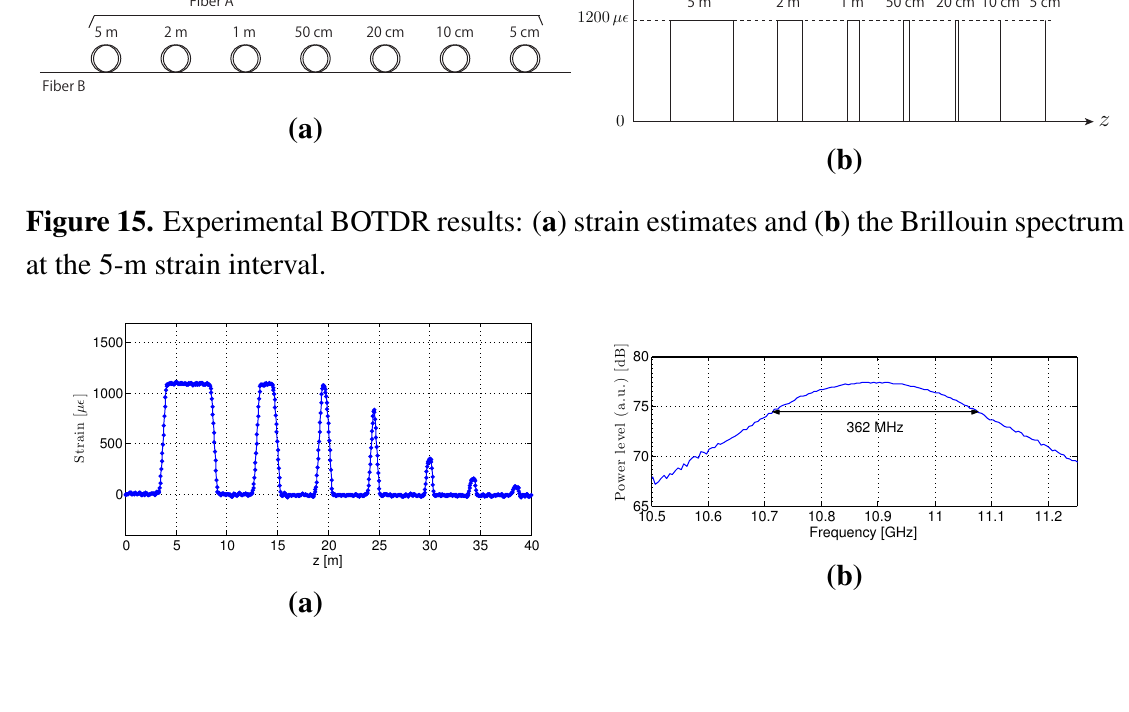
= 1 ns and D = 50 ns: 1 2